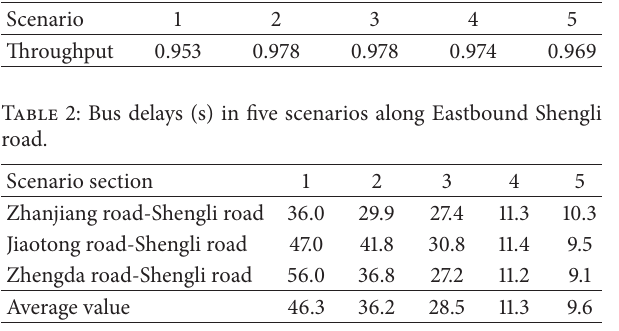
Table 1: Throughput of five scenarios.